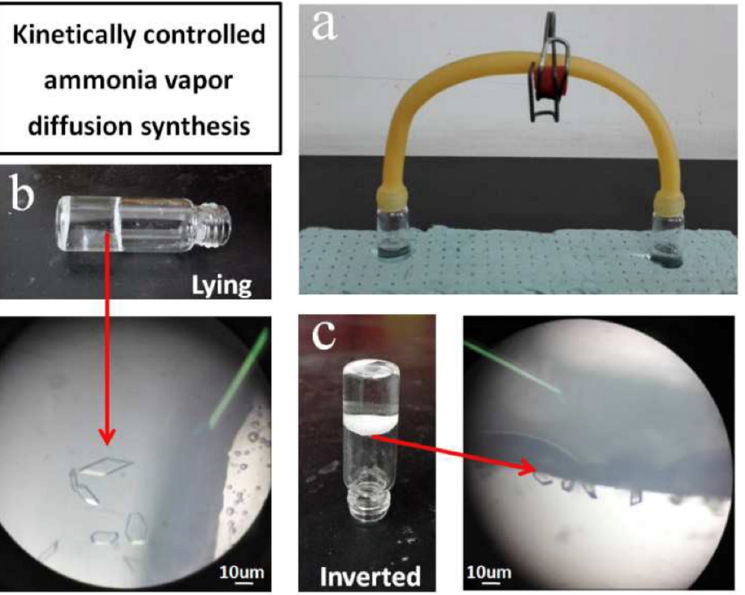
Figure 12. Controlled vapor diffusion synthesis of Zn(INA) 2 (H 2 O) 4 at room temperature. ( a ) appa- ratus for the synthesis; the reaction mixture was in the left-hand vial, ammonia solution was in the right-hand vial. ( b ) the vial lying on its side, crystals on its side wall. ( c ) the vial inverted, crystals at the interface [105].